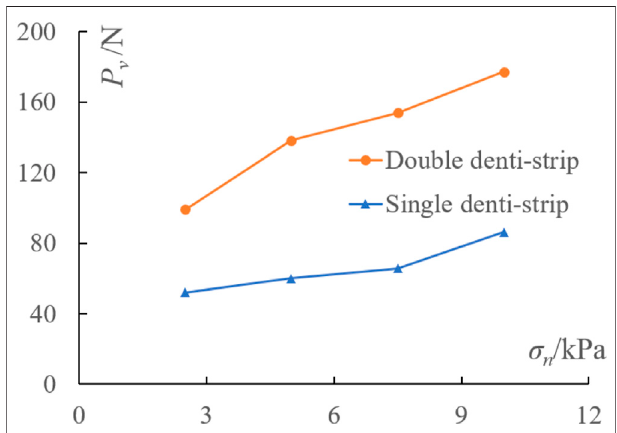
FIGURE 7 | Bearing resistance acting on the